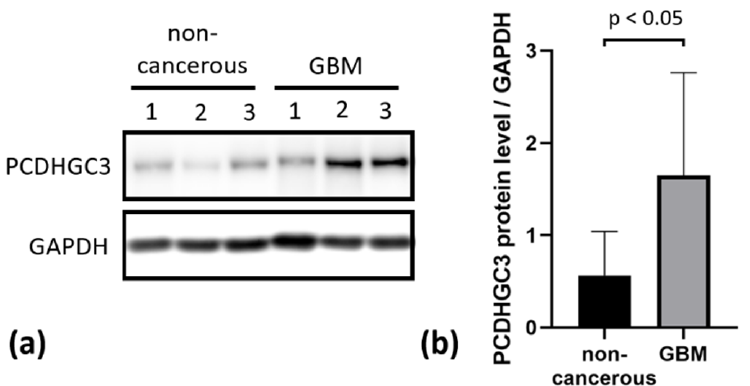
Figure 4. Western blot analysis of PCDHGC3 protein expression in non-cancerous and GBM brain samples. ( a ) Western blot and ( b ) densitometric quantification normalized to the endogenous control GAPDH, non-cancerous n = 7, GBM n = 12. Statistical significance was estimated using the Mann–Whitney